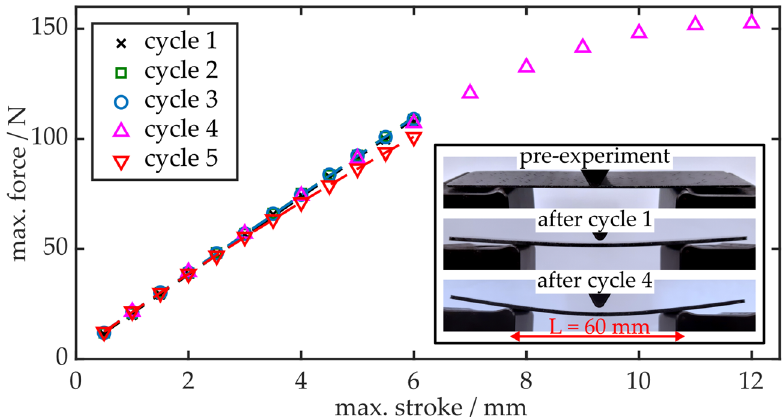
Figure 3. Maximum force as a function of maximum deflection during multiple three-point flexural cycles. The inset shows the sample at the beginning of the experiment and residual deformations after maximum strokes of 6 mm and 12 mm, respectively.